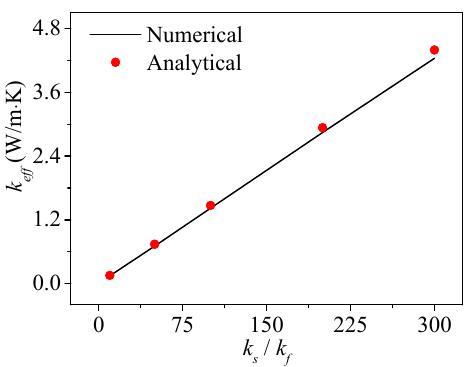
Figure 4. Porous material with periodically distributed and non-interacting pores.